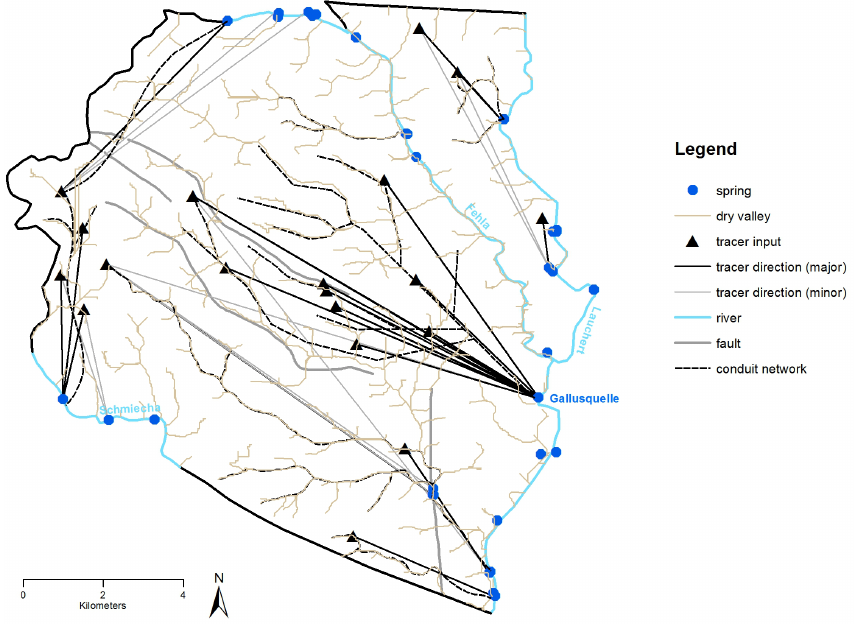
Fig. 3. Top view of the model area. Tracer tests within the area are illustrated with their major and minor registration points (excluded: uncertain registrations and registration points in rivers) after information from the Landesamt für Geologie, Rohstoffe und Bergbau (LGRB). Dry valleys were simulated with ArcGIS ® 10.0 and counterchecked with field observations of Gwinner et al. (1993).